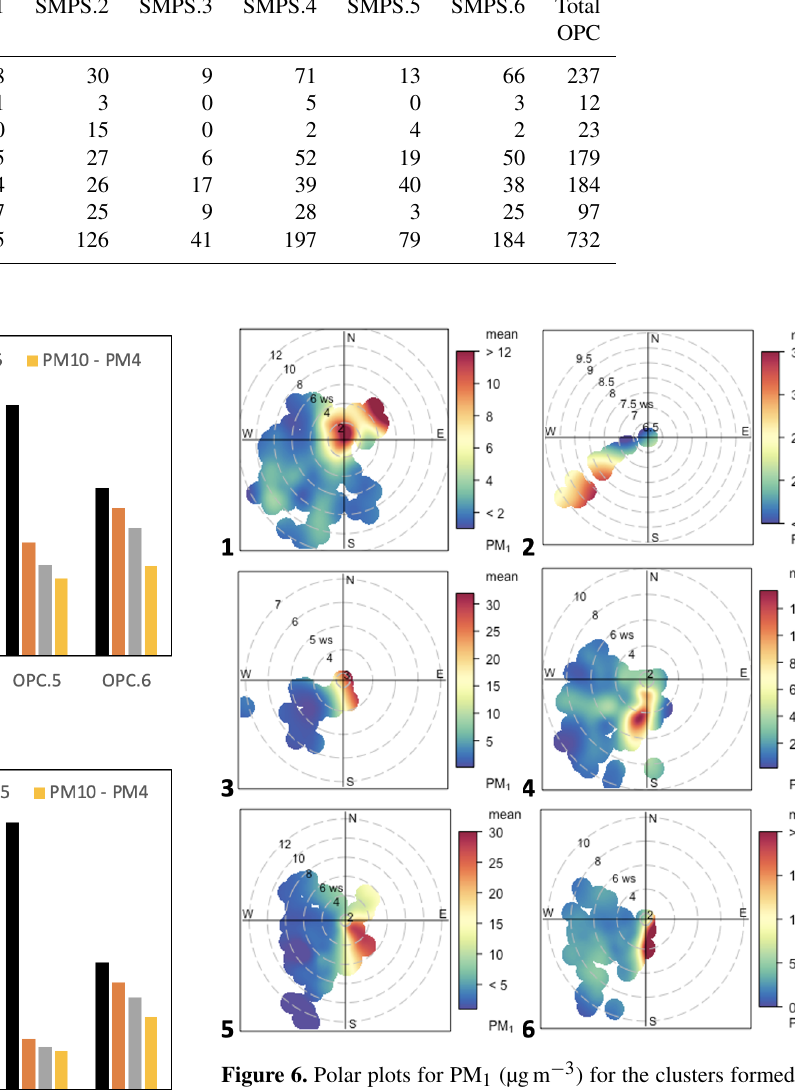
Figure 6. Polar plots for PM 1 (µgm − 3 ) for the clusters formed by the OPC